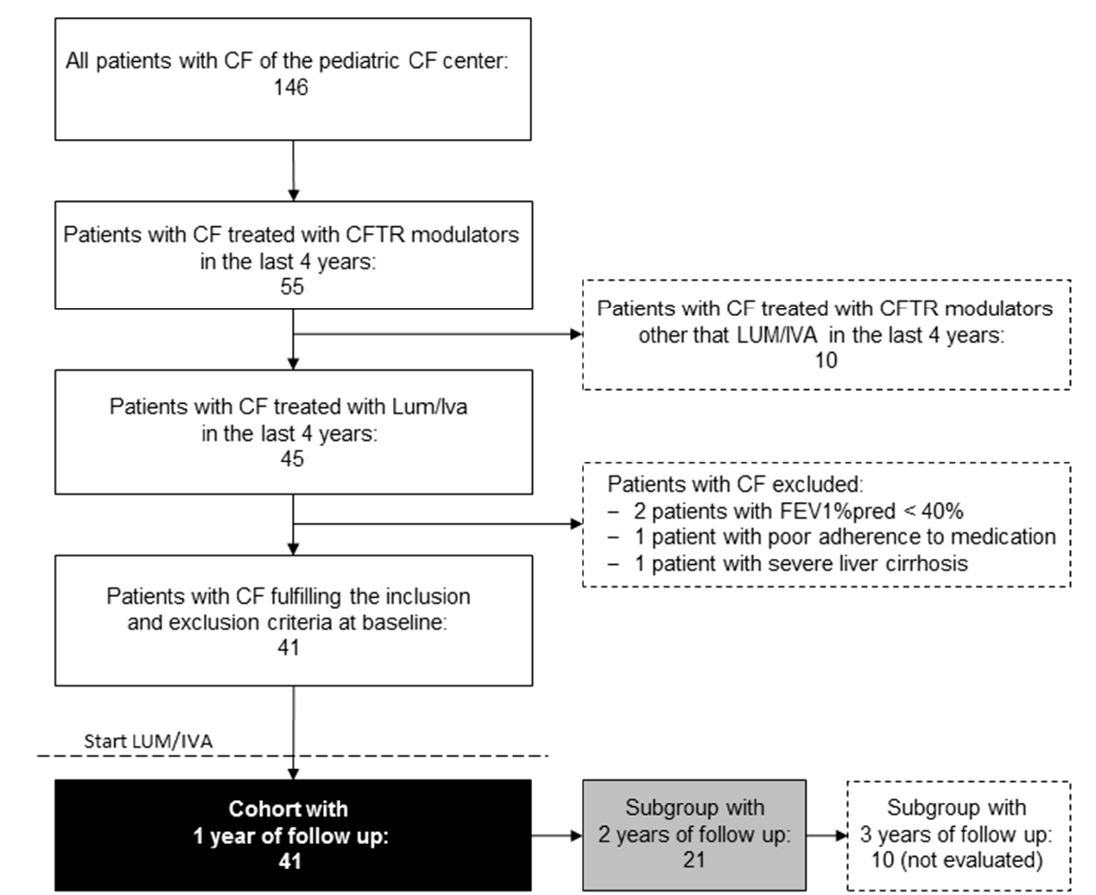
Figure 1. Flow chart showing patient recruitment.